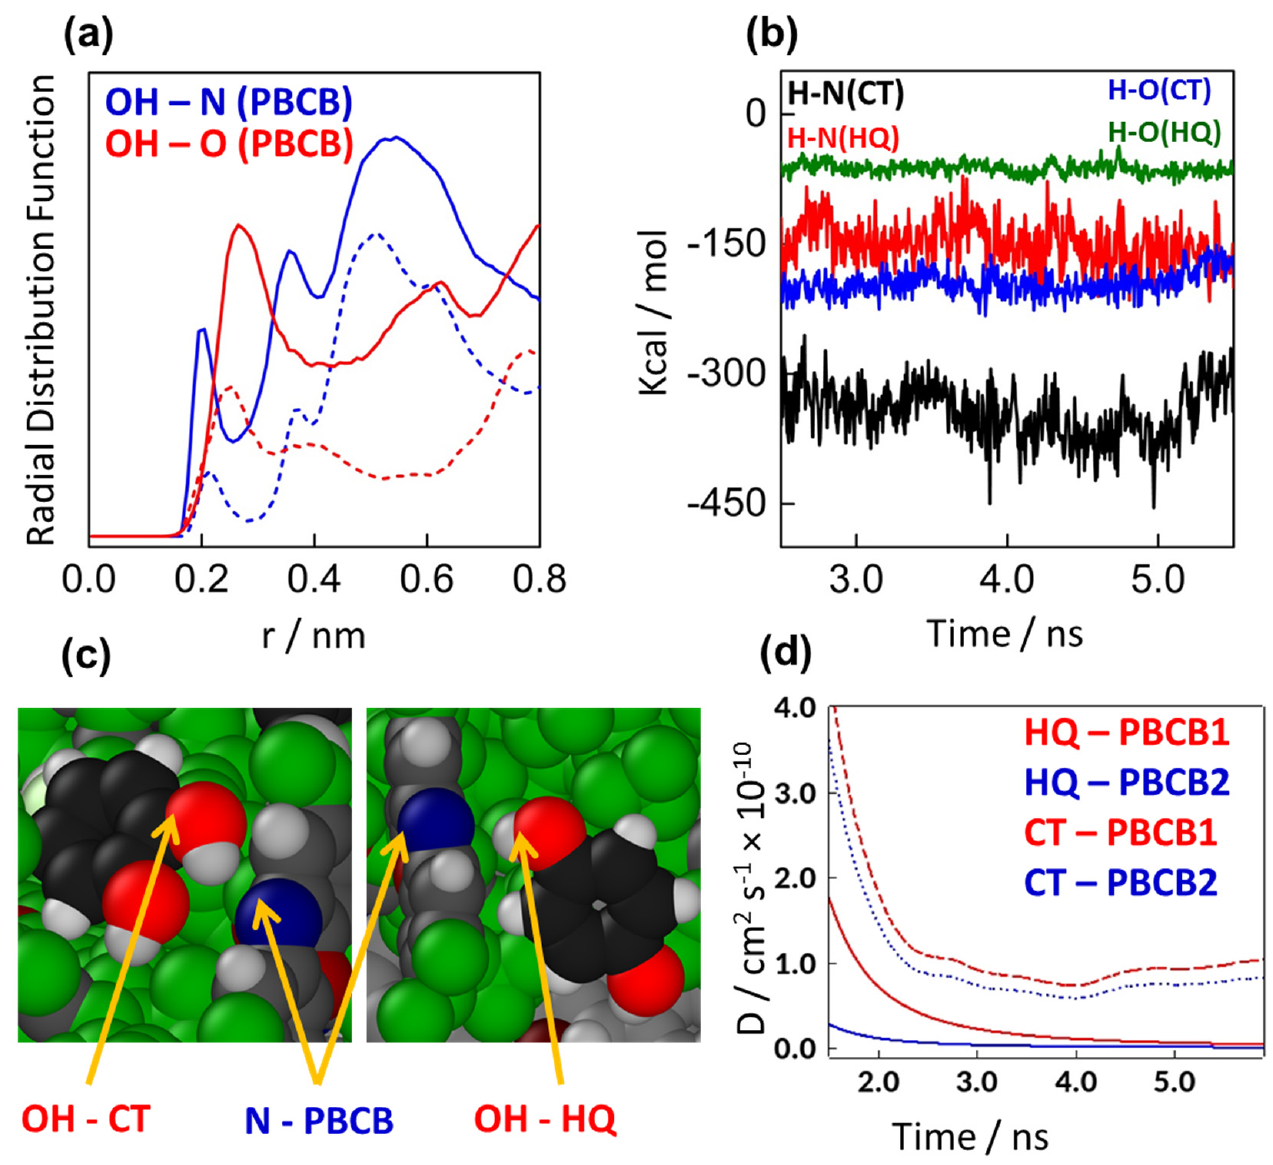
Figure 6. ( a ) Simulated radial distribution function between the H of the OH group and N of PBCB (blue) and O of PBCB (red) in HQ (dotted line) and CT (solid line); ( b ) interaction energy between OH of HQ and N (red), O (green), and OH of CT and N (black) and O (blue); ( c ) simulated snapshots of CT adsorption on PBCB (right) and HQ adsorption on PBCB (left), H (white), O (red), N (blue), C of CT and HQ (black), C of PBCB (gray); ( d ) diffusion coefficient of HQ (dotted line) and CT (solid line) on the surface of PBCB1 (red) and PBCB2 (blue).